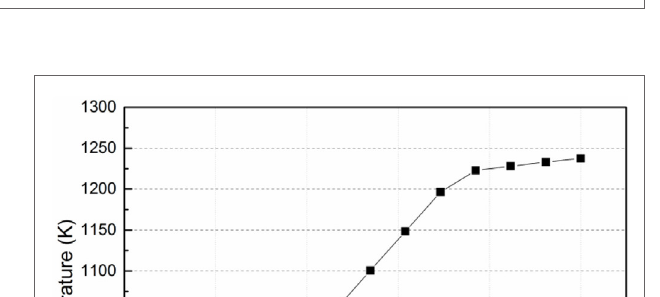
FigUre 10 | Channel in active zone and calculation model.